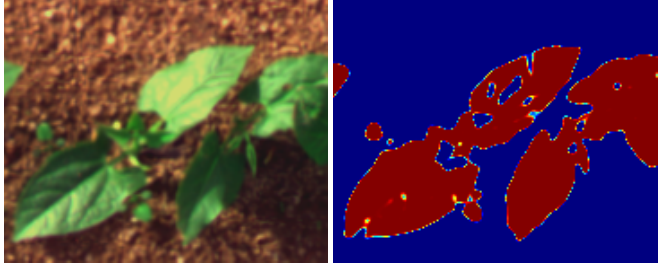
Figure 15. Vegetation/soil discrimination issue caused by specular lights on